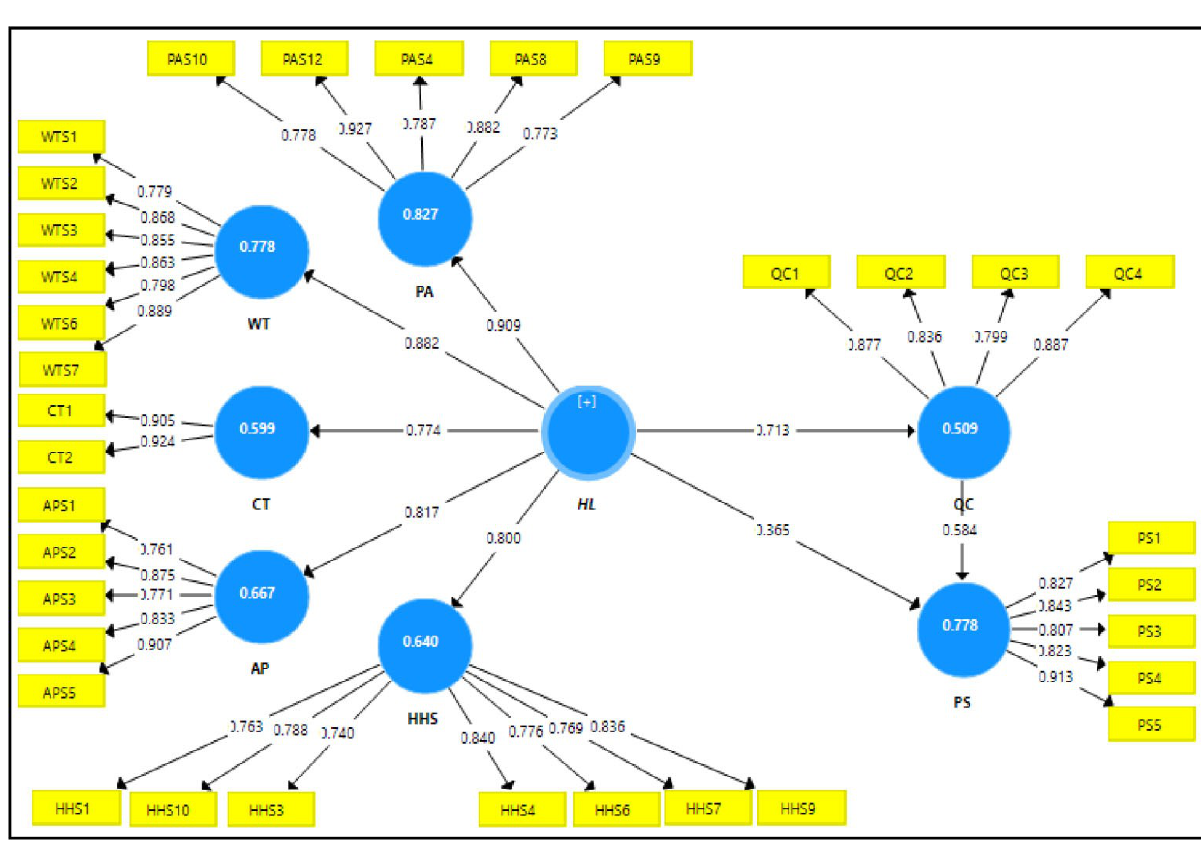
Figure 4. SPC final SEM-PLS model